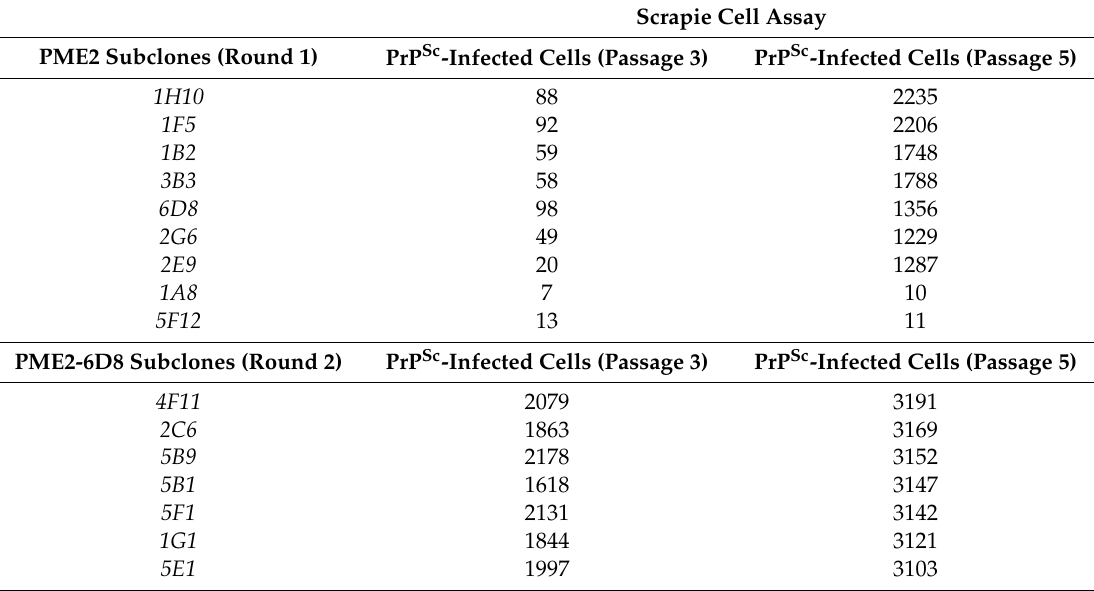
Table 2. Susceptibility of PME2 and PME2-6D8 clones to